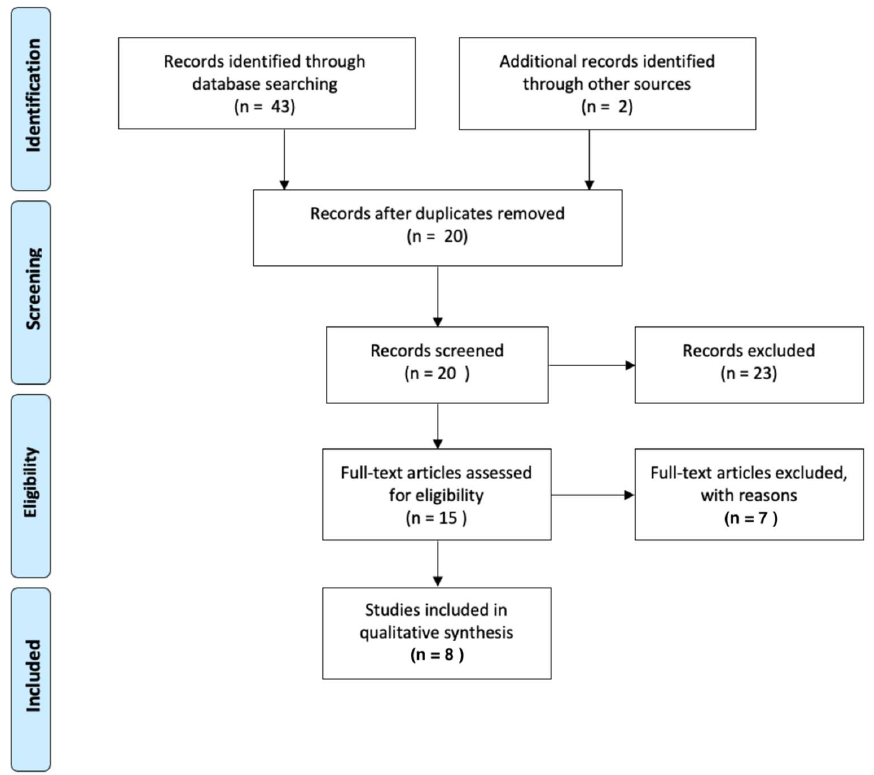
Figure 1. PRISMA (Preferred Reporting Items for Systematic Reviews and